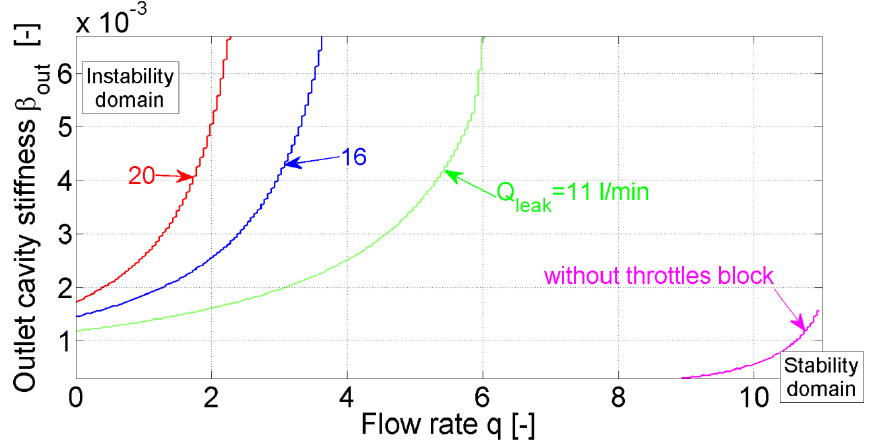
Figure 6. Stability domains at various leakage value Q leak k for the constant areas of throttles 10 and 11 ( A th 1 = A th 2 = 1.77 mm 2 ).